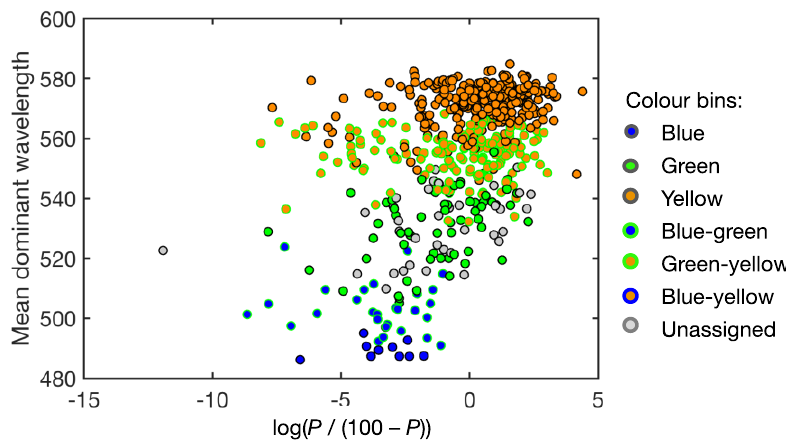
Figure 14. Lake-mean dominant wavelength versus the percentage of land cover by high-producing exotic grassland ( P ) in the lake catchment (after logistic transformation). Dots are colour-coded according to colour bins (Table 1). Table 1 . Colour bins and numbers of lakes in each bin according to their dominant wavelength distribution. Note that the percentages in the right-hand column add up to over 100% as some lakes fit into more than one category.